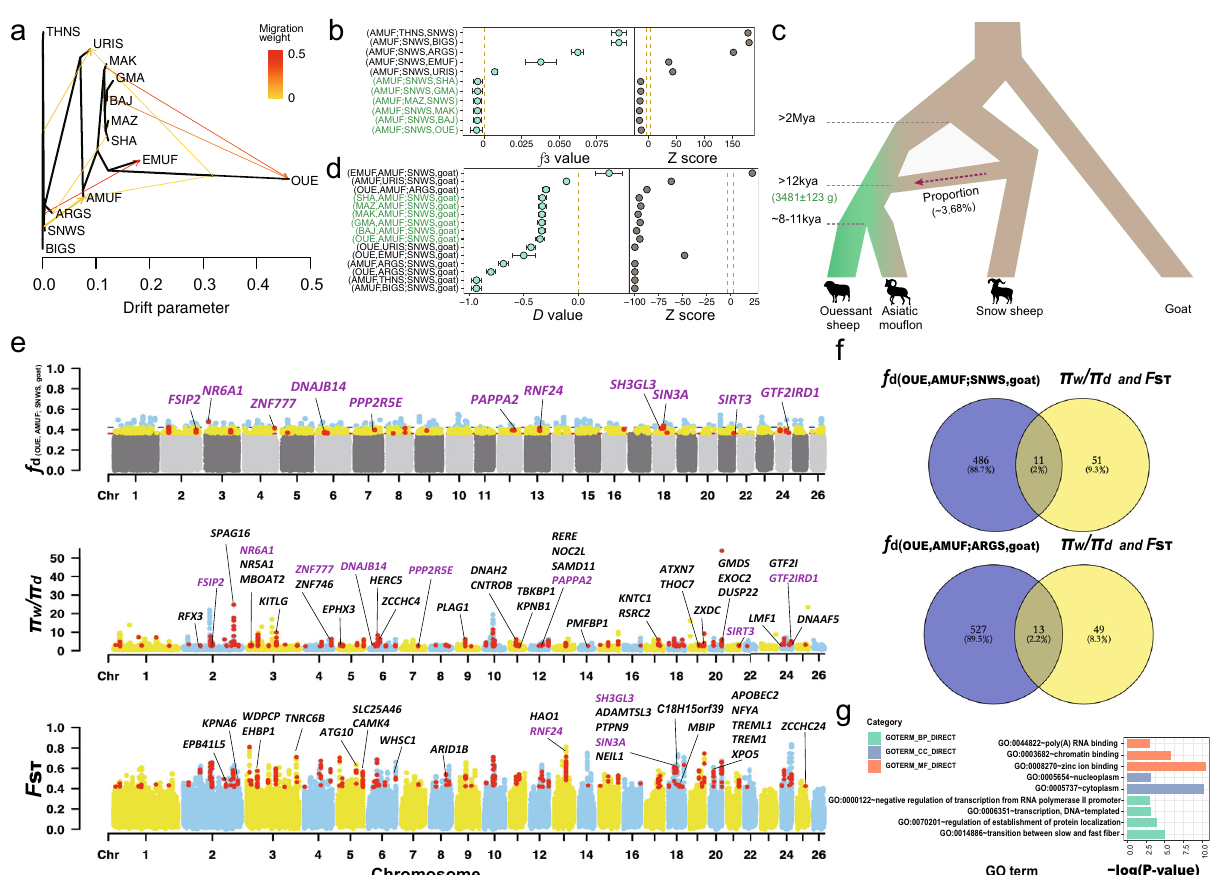
Fig. 5 Local inference and annotation of introgression signals from snow sheep to Asiatic mou fl on. a Treemix analysis when m = 9. b , d f 3 -statistics and D -statistics of Asiatic mou fl on (AMUF) with snow sheep (SNWS) pairs. Double dashed line marked as the range of threshold from -3 to 3. c Demographic diagram of admixture from snow sheep ( O.nivicola ) to Asiatic mou fl on ( O.orientalis ). e Introgressed regions identi fi ed in the Asiatic mou fl on genome. A modi fi ed f -statistic ( f d ) for (OUE,AMUF;SNWS,goat), π ratio ( π w / π d , i.e., π of Asiatic mou fl on/and π of all the domestic sheep) and F ST between Asiatic mou fl on and all the domestic sheep for 100-kb windows with 20-kb steps is plotted along the chromosomes. Each dot represents a 100-kb window. For f - statistic, green and blue dots above the red horizontal line correspond to the FDR 5% and FDR 1% signi fi cance level thresholds, respectively. The regions containing genes among three indexes ( f d , π ratio, and F ST ) are plotted in red dots. For the π ratio ( π w / π d ) and F ST , 340 domestic selection-related windows are plotted, and 62 veri fi ed candidate domestication genes are marked in the plot. Overlapped genes ( n = 11) with f -statistic are marked in purple. f Venn diagram of overlapping genes ( n = 11 for snow sheep and n = 13 for argali) between introgressed genes ( n = 497 for snow sheep and n = 540 for argali) and candidate domestication genes ( n = 62). g GO enrichment for 62 overlapped domestication genes with the previous studies. Source data d – g were presented in Supplementary Data 4 and Supplementary Data